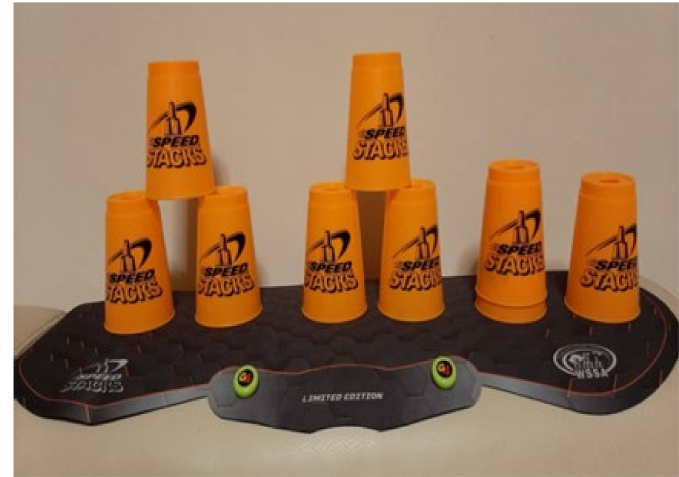
Figure 5. Form a pyramid from the cups in the middle.